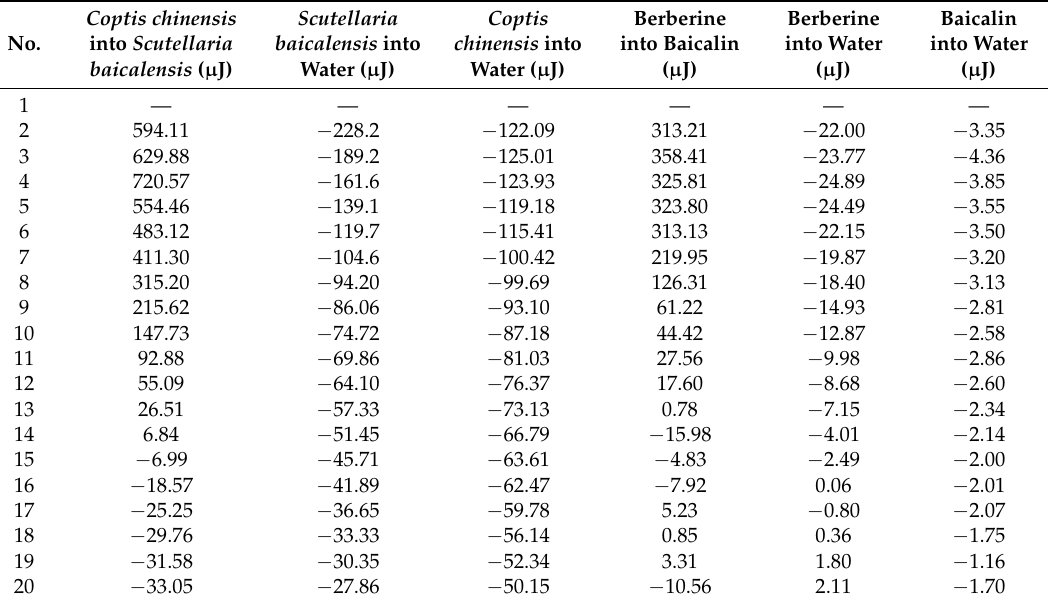
Figure 3. The reactive profiles of colliquefaction ( a ) Calorimetric titration of deionized water with Scutellaria baicalensis decoction; ( b ) Calorimetric titration of deionized water with Coptis chinensis decoction; ( c ) Calorimetric titration of Scutellaria baicalensis decoction with Coptis chinensis decoction. Table 3. Binding heat of all